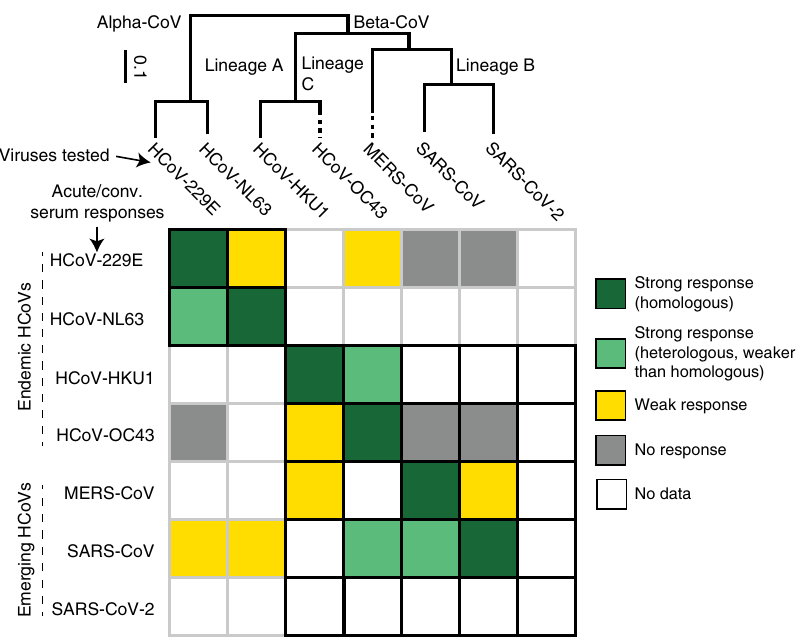
Fig. 4 Antigenic and phylogenetic relationships among HCoVs. Ordinal qualitative summary of the reactivity of antisera (rows) provided by individuals with con fi rmed infections with each human coronavirus against the panel of human coronaviruses (columns), shown in relation to their phylogeny 151 . Cell color indicates the magnitude of change in the antibody response (measured by neutralization assay, IFA, and/or enzyme-linked immunosorbent assays (ELISA) or western blot to N or S proteins) between acute and convalescent samples with dark green indicating strong, homologous response, light green indicating strong, heterologous response, yellow indicating weak response, and gray indicating no response. White boxes indicate that no data are available. The black grid indicates relationships between viruses of the same genera. Note that in some cases, cross-reactivity may be due to stimulation of immunity to previous infections (e.g., SARS-CoV serological responses toward HCoV-OC43), and in other cases, to relatedness of the viruses (SARS-CoV serological responses toward